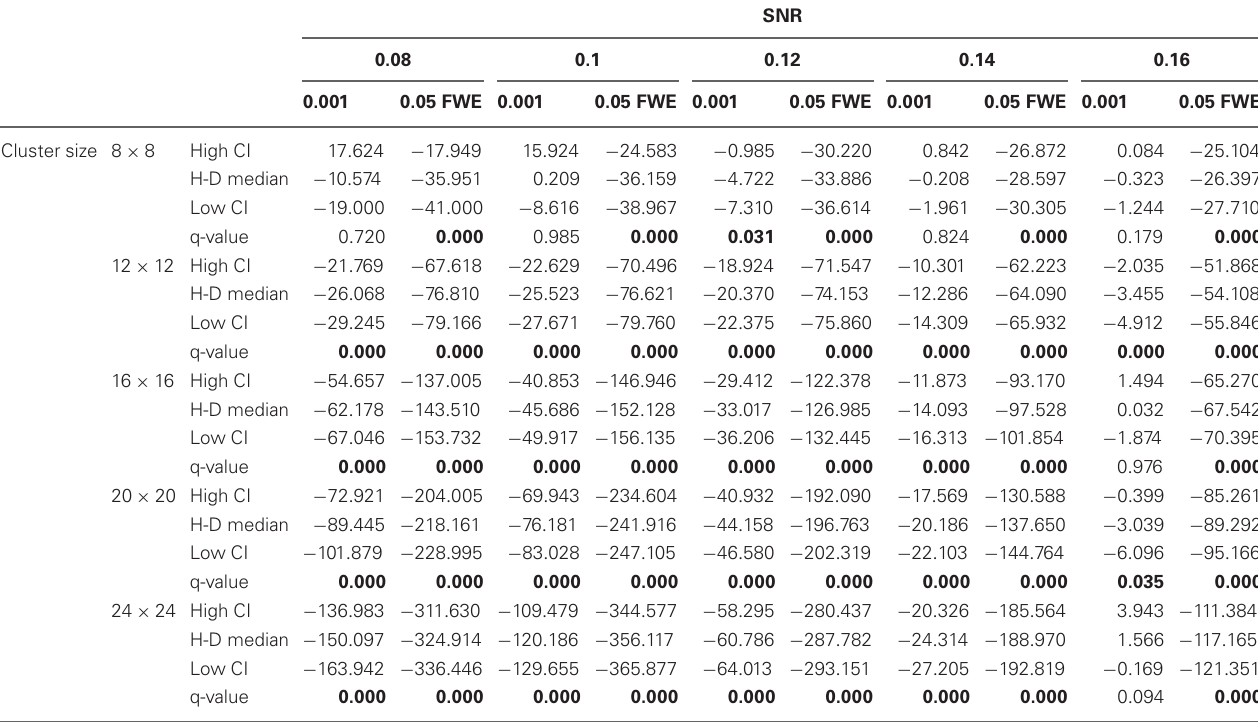
Q-Values correspond to p-values that were corrected for multiple comparisons using B-H method for controling FDR. Statistically significant tests are highlighted in